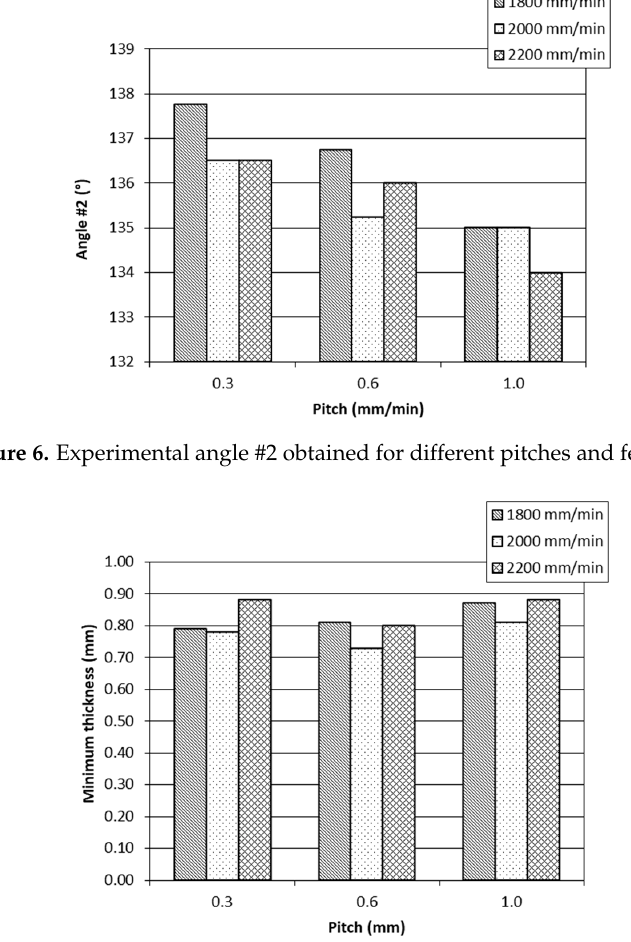
Figure 9. Normalized springback, for different pitches and feed-rates. The area between the theoretical profile and the real one for each mold is shown in Figure 10. This area gives an idea of the overall error existing between the sought-after piece and the one obtained.